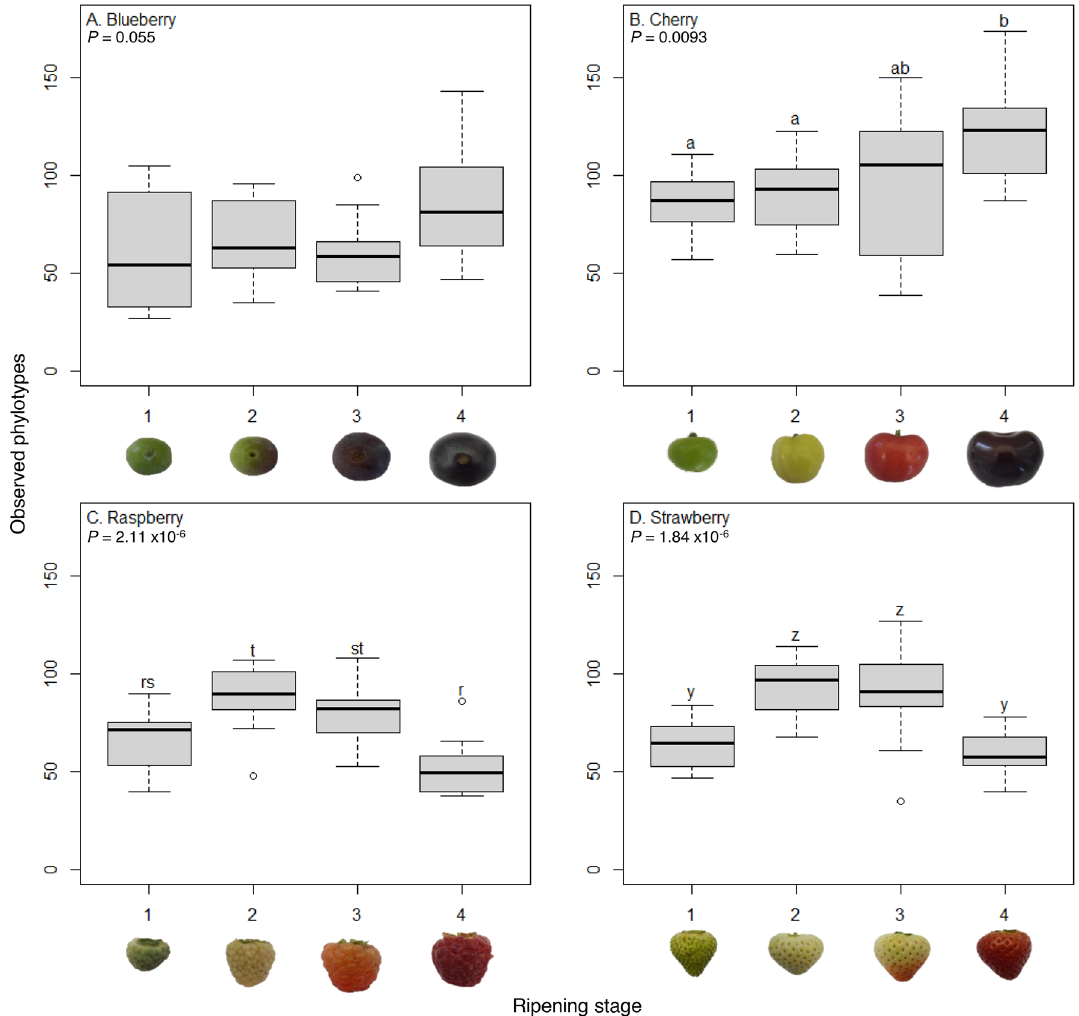
Figure 2. Number of observed phylotypes across fruit types and maturation stages. Number of fungal phylotypes across four ripening stages (1, unripe/green fruit; 2, de-greening fruit; 3, ripening fruit; and 4, fully ripe/harvest fruit) for blueberry, cherry, raspberry and strawberry (N = 12 except N = 11 for strawberry stage 3). Numbers of fungal phylotypes differ across ripening stages for cherry, raspberry and strawberry but not blueberry (ANOVA, P values shown). Where significant, different lowercase letters represent significant differences in phylotype numbers within each fruit ( P < 0.028) with separate Dunn’s comparisons post-hoc (with Benjamini–Hochberg multiple comparison correction). Different letter groups show any significant differences between ripening stages within each fruit